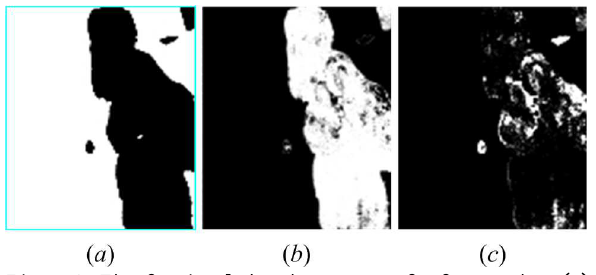
Figure 3. The fractional abundance map of reference data ( a ) water, ( b ) bare soil / deciduous tree and ( c ) evergreen